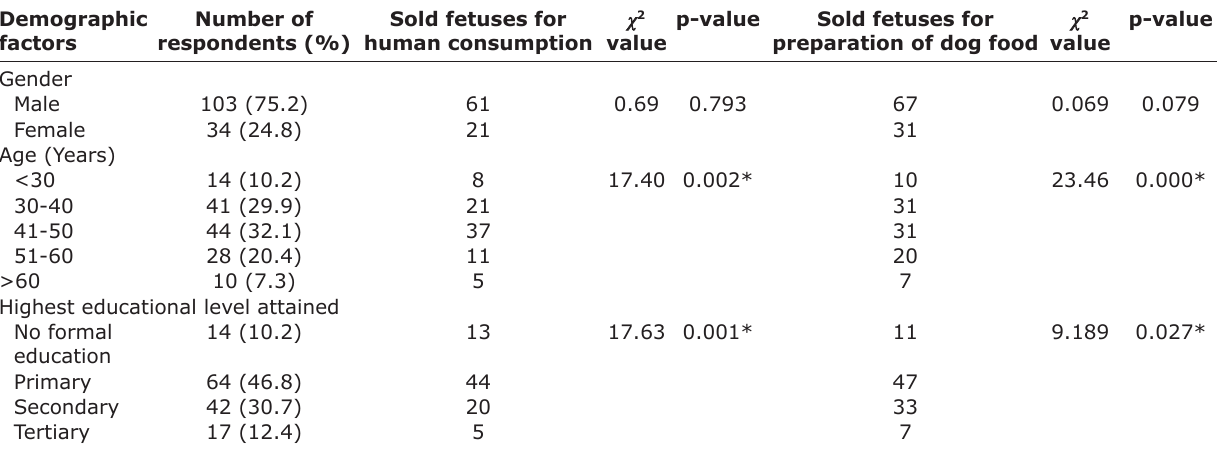
*Denotes statistically significant P values, SHWs=Slaughterhouse workers, PPC=Personal protective clothing Table-7: Association between the method of disposal of eviscerated fetuses and demographics and educational levels of SHWs (n=137) surveyed in Enugu State, Nigeria. Demographic